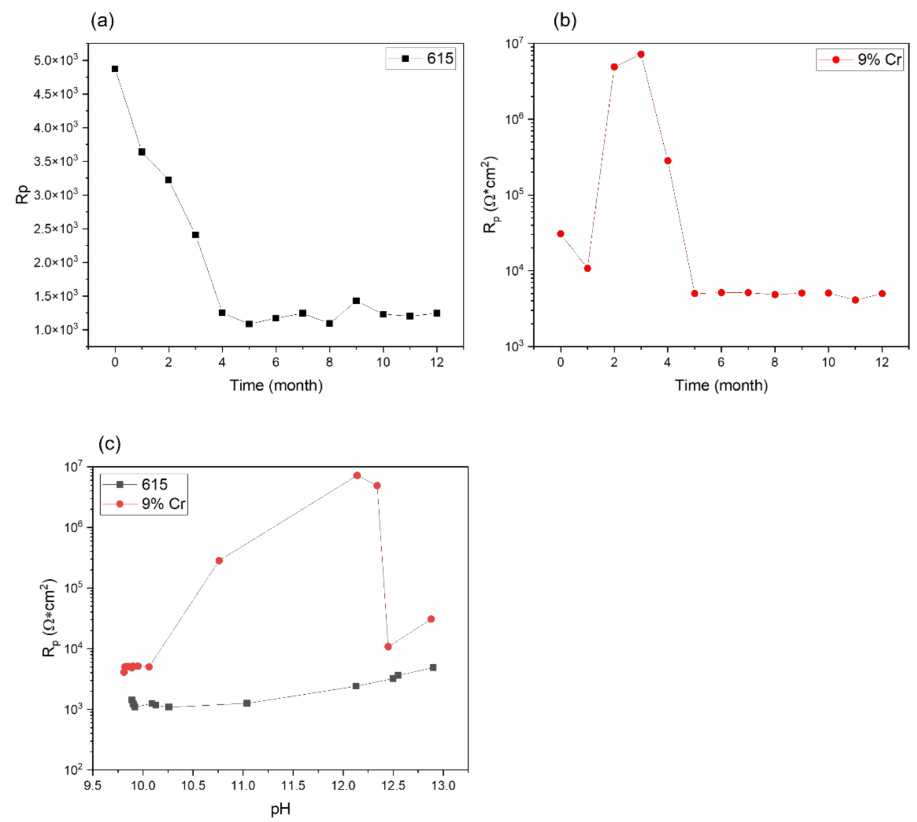
Figure 6. Summary of R p for both 615 and 9% Cr rebars in SCPS with 3.5 wt% NaCl as a function of